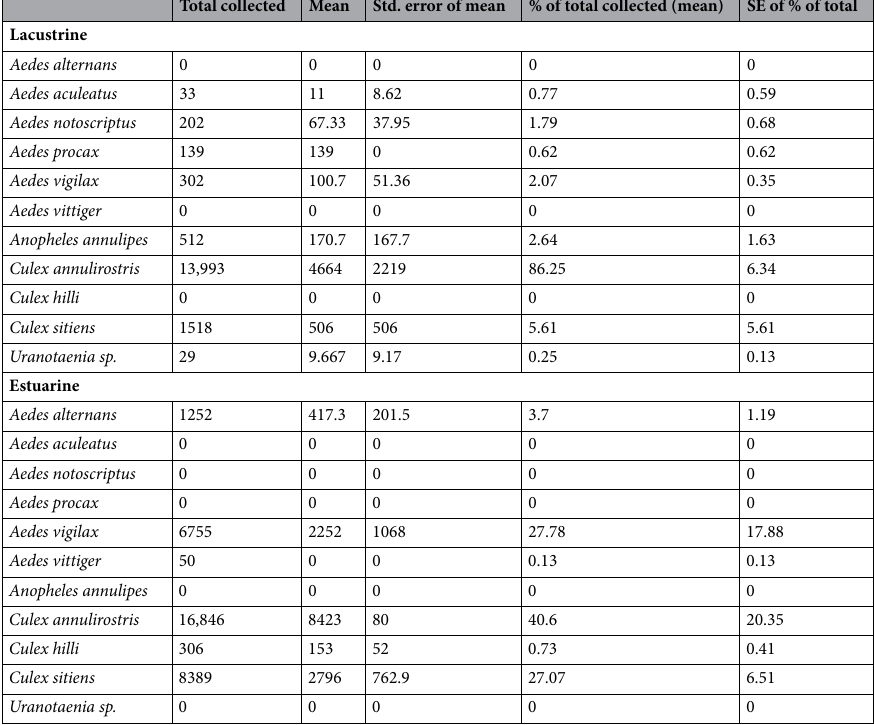
Table 6. Summary of mosquito species collected in each surveyed environment. Two CO 2 -baited light traps were set at each sampling site across four (n = 4) surveillance